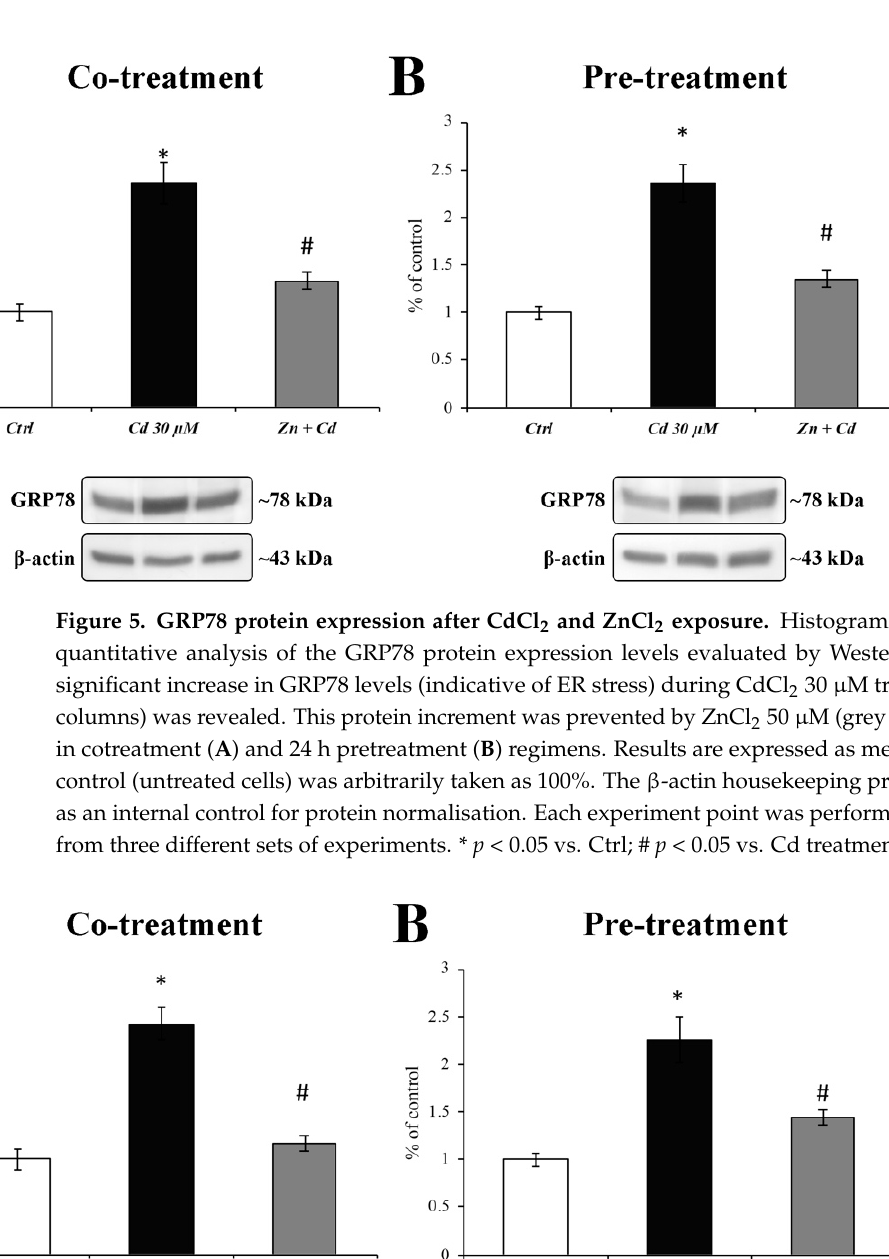
Figure 6. BAX protein expression after CdCl 2 and ZnCl 2 exposure. The histograms show the quantitative analysis of BAX protein expression levels, evaluated by Western blotting. When RBE4 cells were treated with CdCl 2 30 µ M for 24 h, BAX expression significantly increased (black columns). This effect was counteracted when cells were cotreatment ( A ) and 24 h pretreatment ( B ) with ZnCl 2 50 µ M (grey columns). Results are expressed as mean ± SEM, and control (untreated cells) was arbitrarily taken as 100%. The β -actin housekeeping protein was used as an internal control for protein normalisation. Each experiment point was performed in triplicate, from three different sets of experiments. * p < 0.05 vs. Ctrl; # p < 0.05 vs. Cd